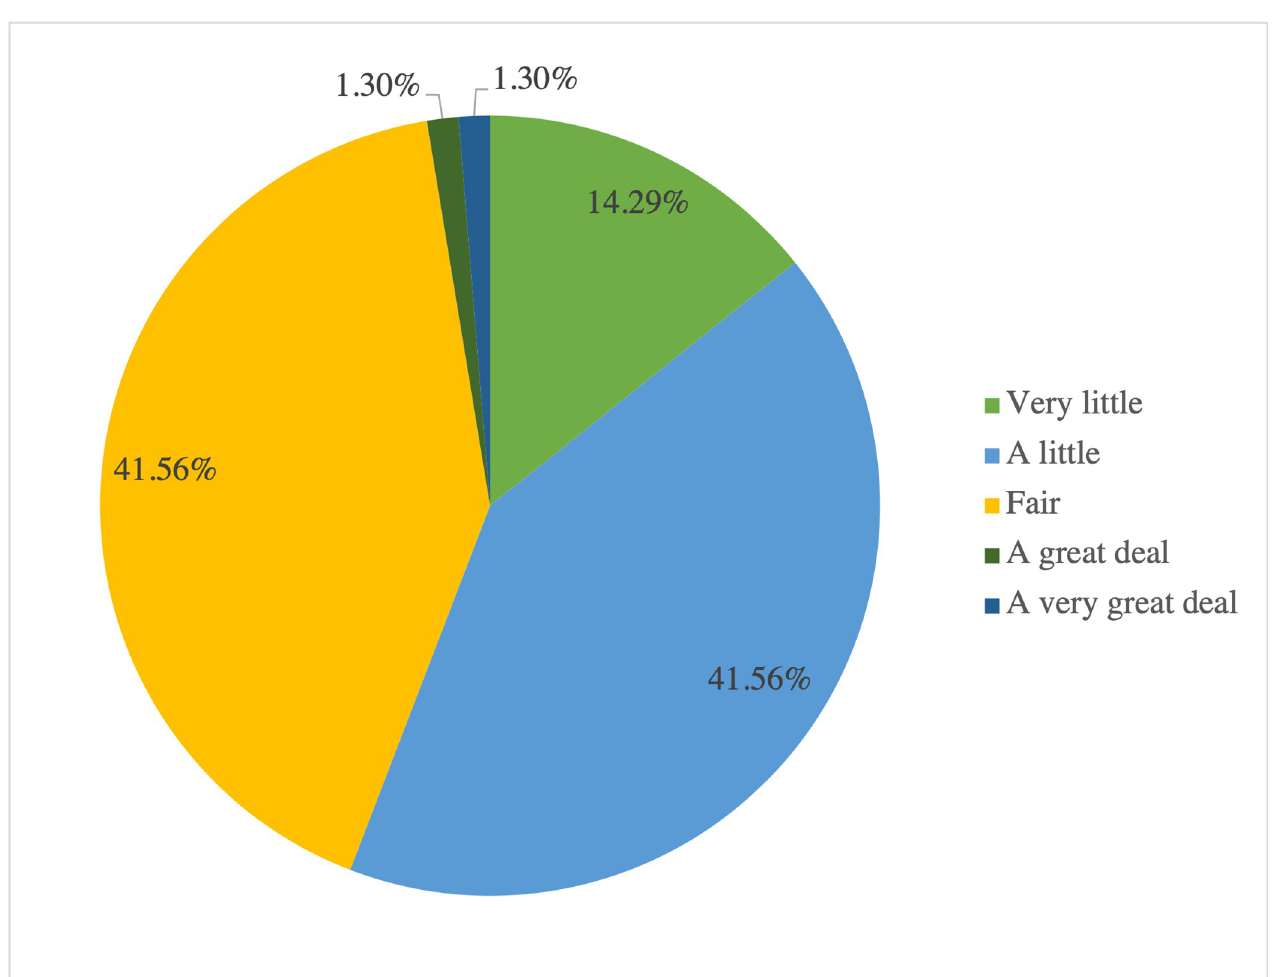
Fig 2. Respondents’ self-descriptions of their level of understanding of childhood apraxia of speech.